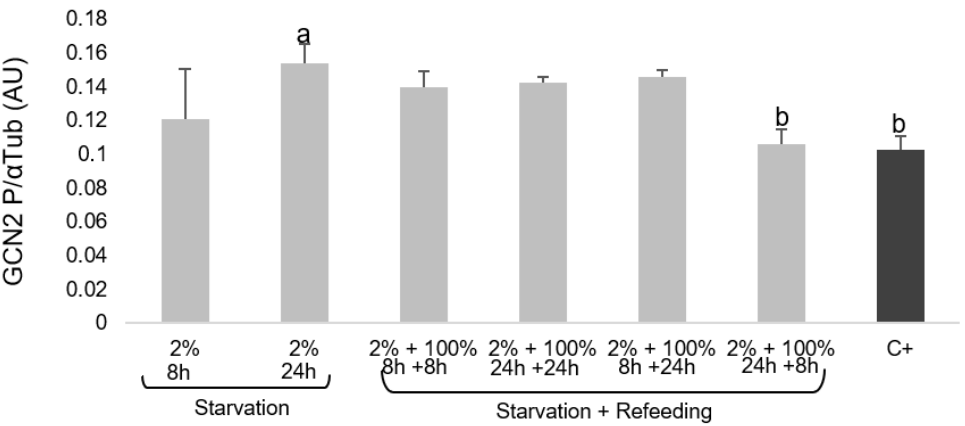
Figure 2. Total and phosphorylated GCN2 expression in MECs cultured for 6 days. EAAs were added at concentrations of 2% (starvation) and 100% (cells not depleted: control, C+) for 8 and 24 h, followed by refeeding with 100% EAAs for 8 and 24 h. Columns with different letters indicate significant differences. GCN2: general control nonderepressible 2; MEC: mammary epithelial cell; EAA: essential amino acid.